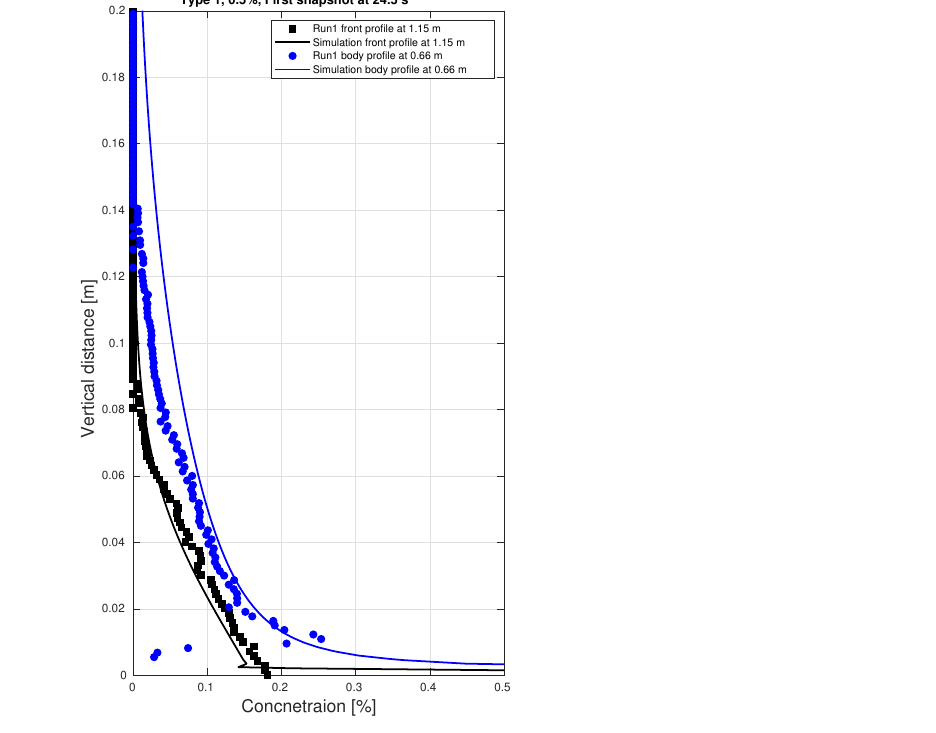
Figure 14. Validation case for run1. Vertical concentration profiles are shown for the front and the body of the current. The first snapshot is taken when the front of the current has almost reached the middle of the tank.